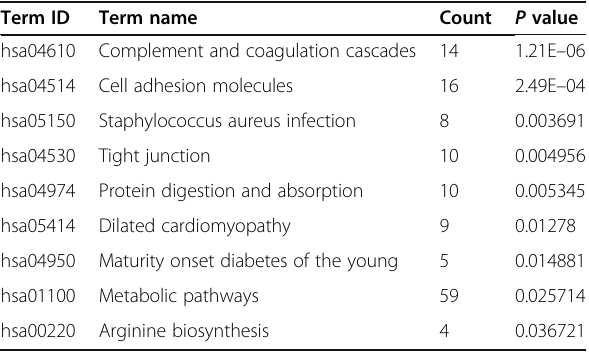
Table 4 The pathway analyses of downregulated genes Term